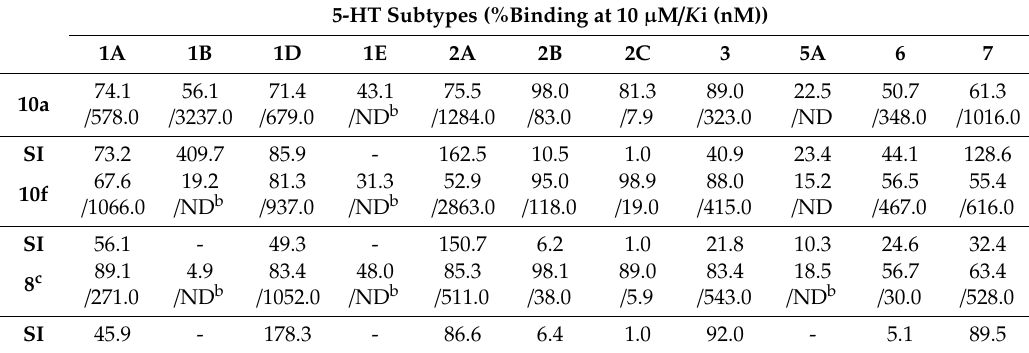
Table 3. Evaluation of binding a ffi nity of 10a and 10f to 5-HT receptor subtypes a .